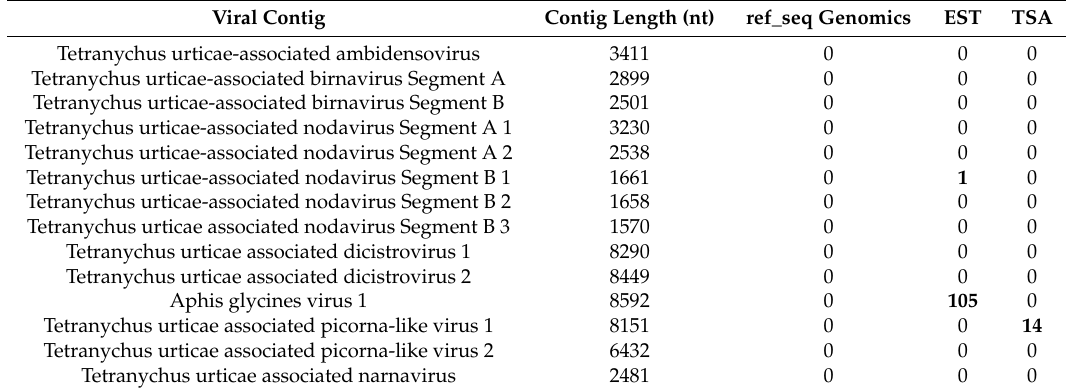
Table 2. Summary of the number of sequences found in the Tetranychus urticae genomic and/or transcriptomic databases that display homologies with viral species discovered in the viromes generated in this study.